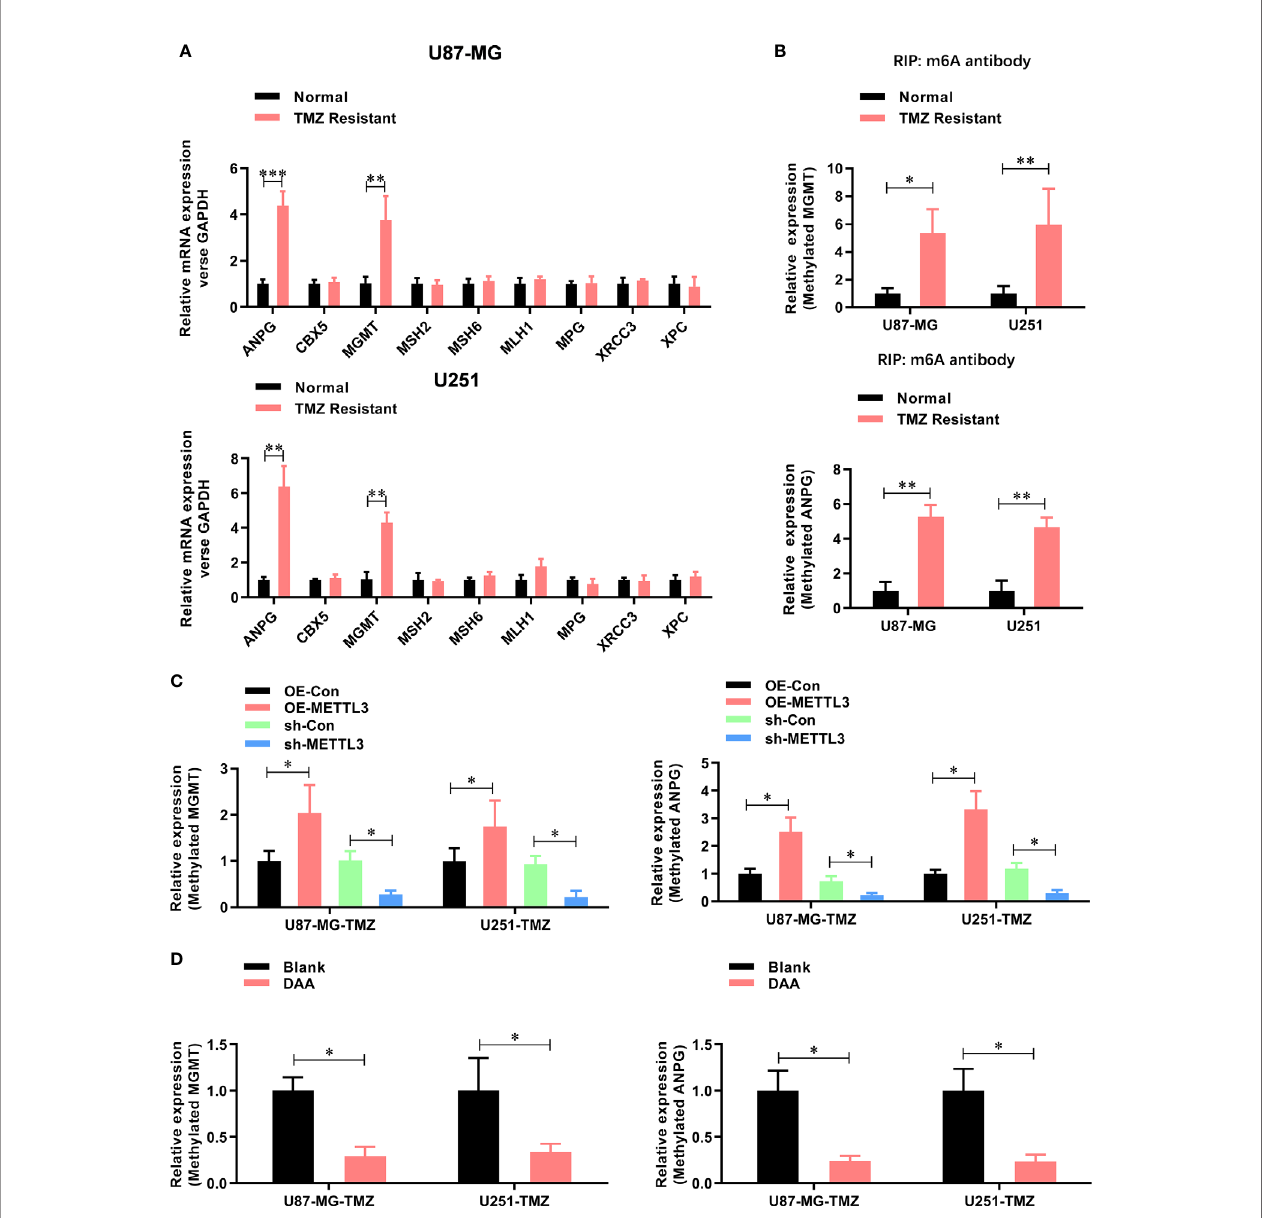
FIGURE 4 | METTL3 contributes to the TMZ resistance via m 6 A modi fi cation of MGMT and ANPG mRNAs. (A) The expression mRNA level of TMZ resistant genes (ANPG, CBX5, MGMT, MSH2, MSH6, MLH1, MPG, XRCC3, and XPC) in normal and TMZ-resistant U87-MG/U251 cells were analyzed by real-time PCR. (B) The m 6 A-methylated level of MGMT and ANPG in normal and TMZ resistant U87-MG/U251 cells were analyzed by Me-RIP-real-time PCR. (C) The effect of METTL3 overexpression and knockdown on the m 6 A methylated level of MGMT and ANPG were analyzed by Me-RIP-real-time PCR. (D) The effect of DAA treatment on the m 6 A-methylated level of MGMT and ANPG were analyzed by Me-RIP-real-time PCR. * P < 0.05 and ** P < 0.01 versus indicated control U87-MG/U251